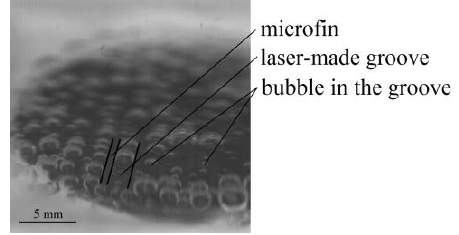
Figure 16. Vapor bubbles on a laser-treated surface.